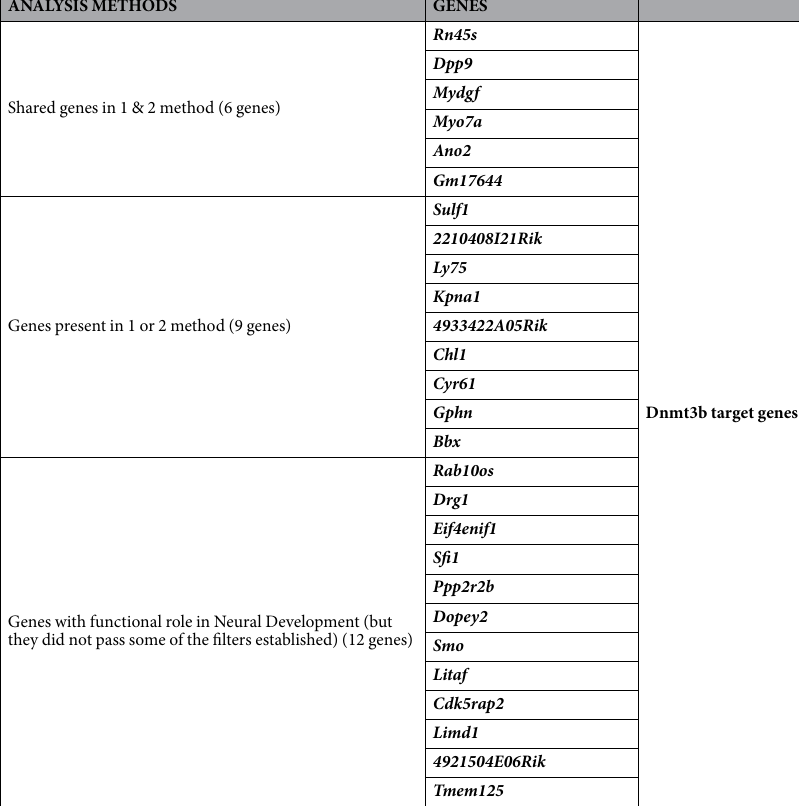
Table 1. Selected genes in mouse-NLBS.